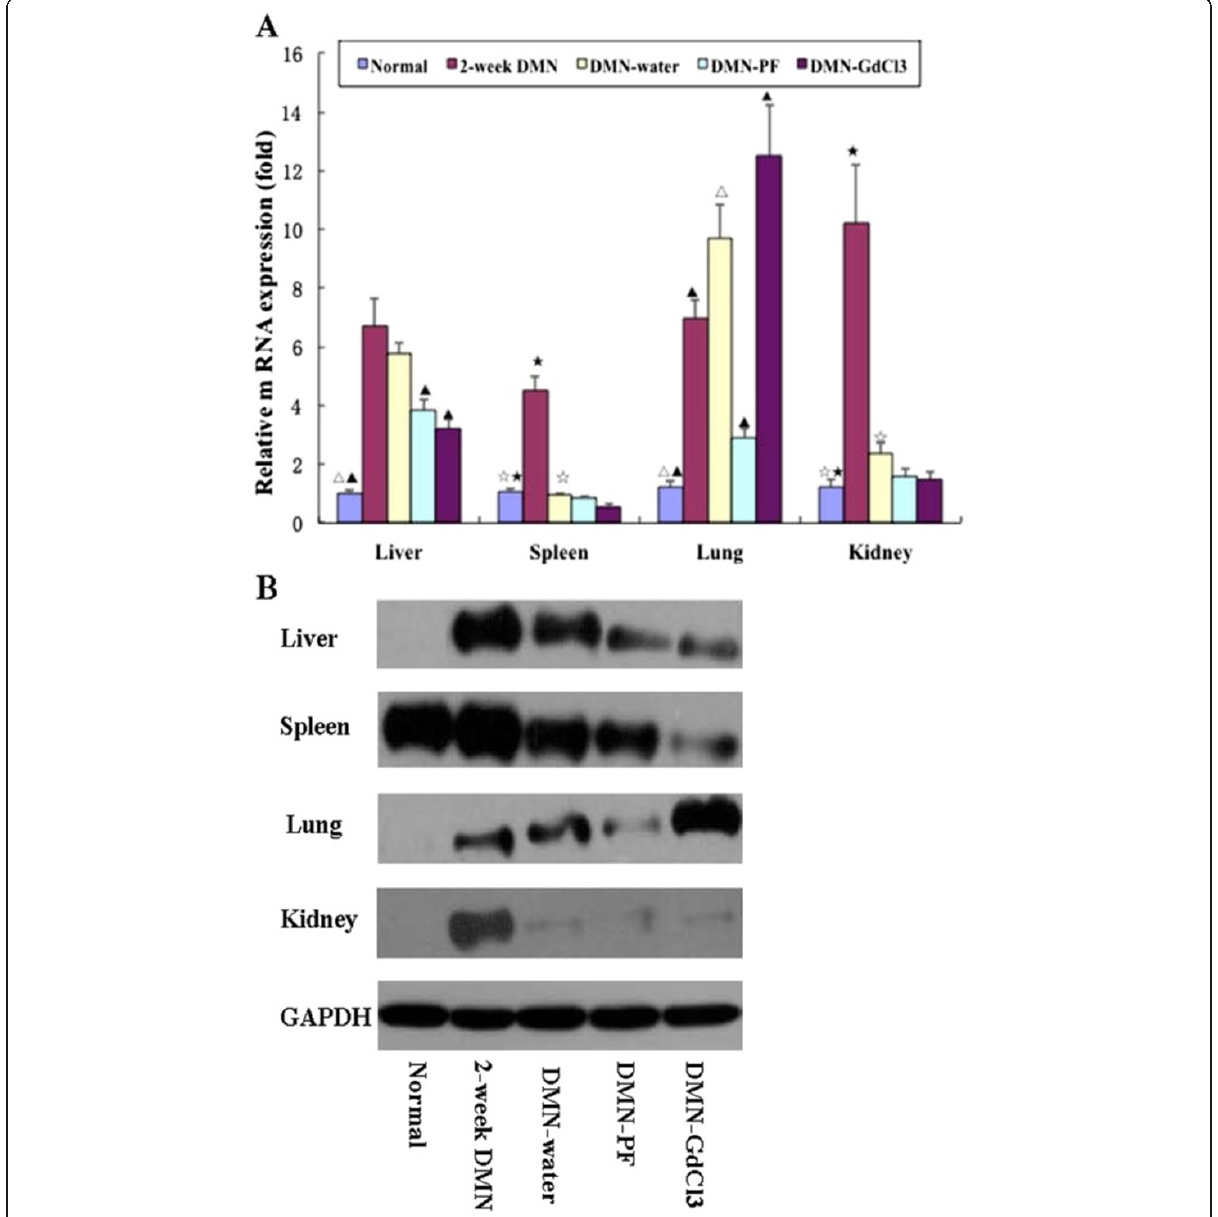
Figure 4 Effects of PF on CD68 expression in different organs in DMN-induced rat liver fibrosis. ( A ) CD68 was measured by real-time PCR. As an internal control, 18S rRNA was amplified. The data represented the mean ± SD. ▴ p <0.05 and ▴▴ p <0.01 versus DMN-water rats; △ p <0.05 and △△ p <0.01 versus 2-week DMN rats; LSD test were used for group comparisons in CD68 detection in the liver and lung. ☆ p <0.05 versus 2-week DMN rats; ⋆ p <0.05 versus DMN-water rats Kruskal-Wallis test were used for group comparisons in CD68 detection in the spleen and kidney, n=3. ( B ) CD68 were detecting by western